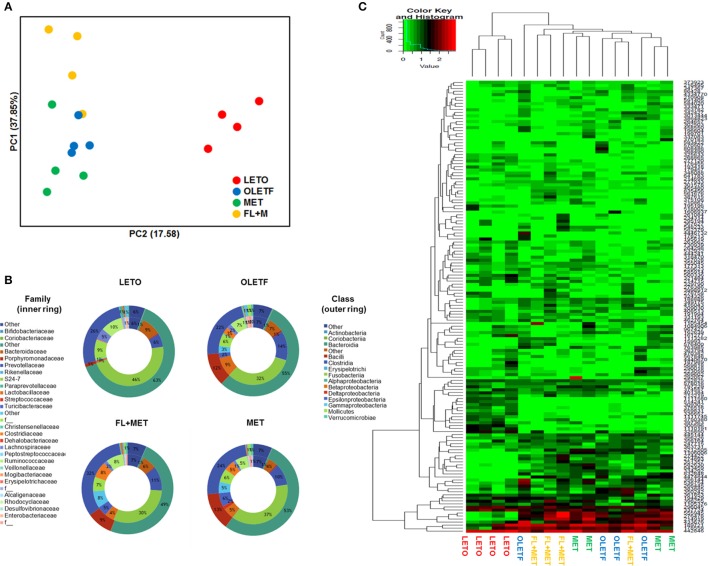
Alteration of structure of gut microbiota by FL in OLETF rats. (A) PCoA score plot calculated from OTU levels by QIIME was subjected to unweighted UniFrac analysis. (B) Composition profiles of gut microbiota at family and class levels. (C) Heatmap and clustering of individual gut microbiota in 150 OTUs.